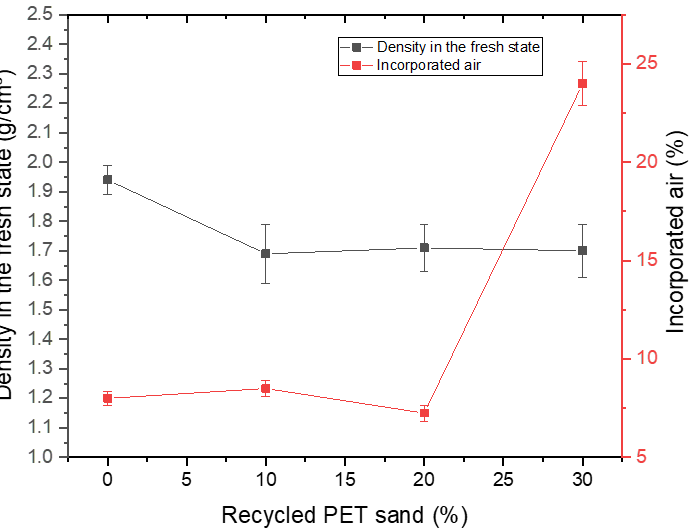
Figure 3. Density results in fresh state and incorporated air.